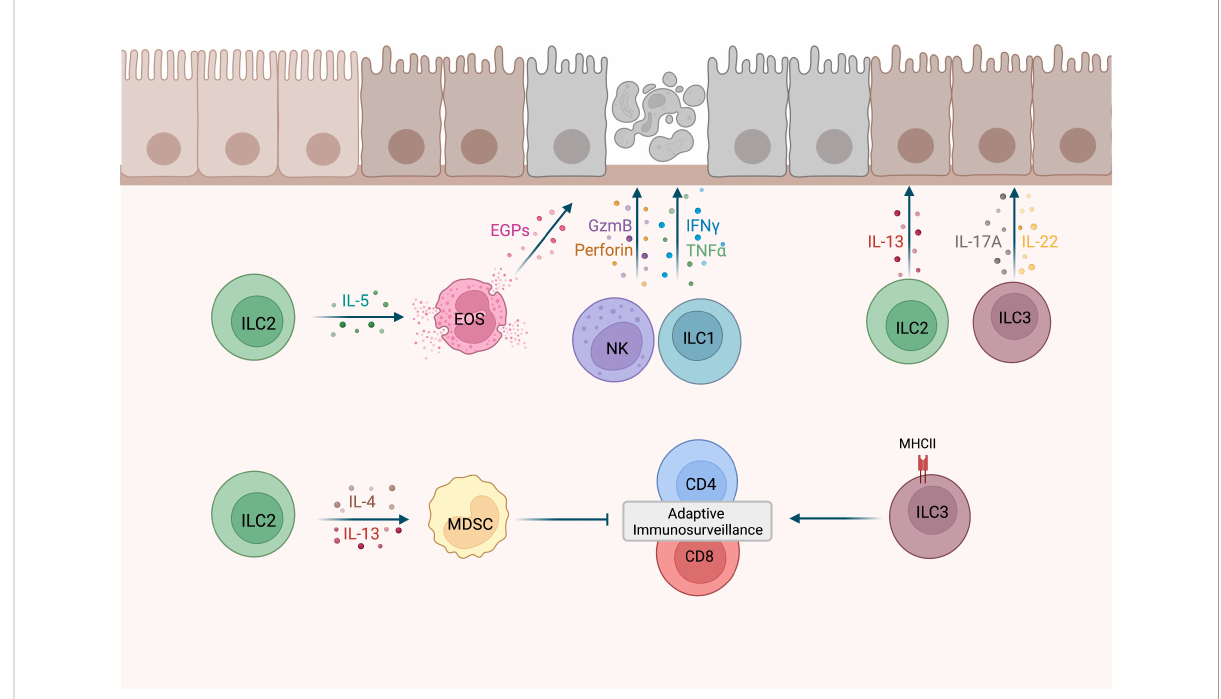
FIGURE 1 Potential roles of ILCs during tumor development. NK cells and ILC1s have shown cytotoxic activity against precancerous cells (12, 13, 20). IL-5- secreting ILC2s may recruit eosinophils (EOS) to precancerous tissues and activate cytotoxic effector functions in EOS, such as the release of eosinophilic granule proteins (EGPs) (21, 22). MHCII + ILC3s were shown to promote CD4 and CD8 cell responses to prevent tumor development (23). Conversely, ILC2s may drive MDSCs activation and subsequent T cell suppression via IL-4 and IL-13 secretion (24), as well as metaplasia development via the release of IL-13 (25). IL-17A and IL-22 expression by ILC3s may promote clonal expansion of precancerous cells (26). This fi gure has been created with